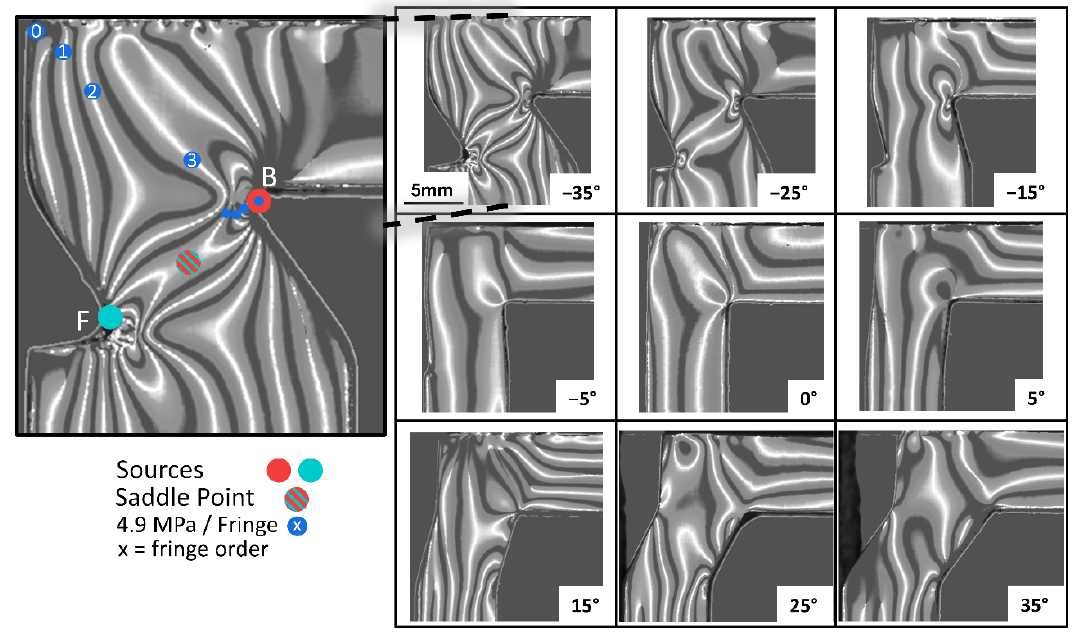
Figure 3. The stress-optical rings (numbered in ascending order) of polymer unit cells are shown for angles θ = − 35° and 35°. In the magnification of θ = − 35°, the starting points B and F of the rings and the saddle point between both rings are shown. The lowest stress occurred at the saddle point.